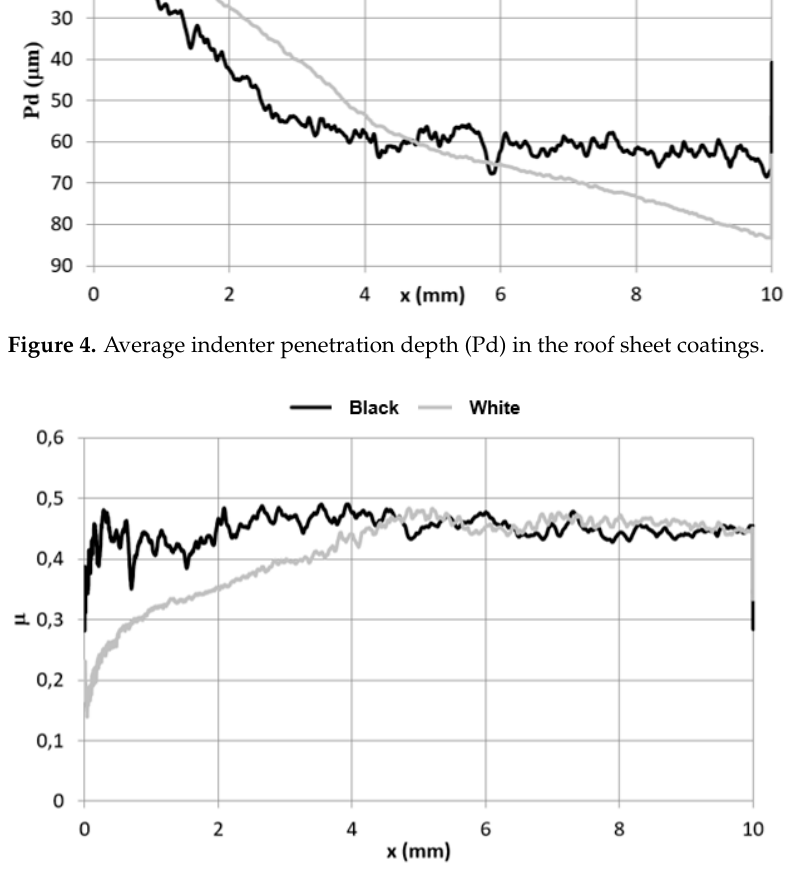
Figure 6. Optical microscope image of the scratched “black” protective coating (Olympus, objective, with 20× magnification, aperture of 0.4).